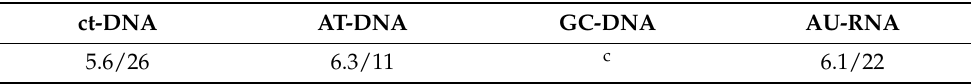
Table 3. Binding constants and emission changes ( a log Ks (M − 1 )/ b ∆ Int(%)) of open DAE-NH-Py complexes with ds-polynucleotides calculated by processing fluorimetric